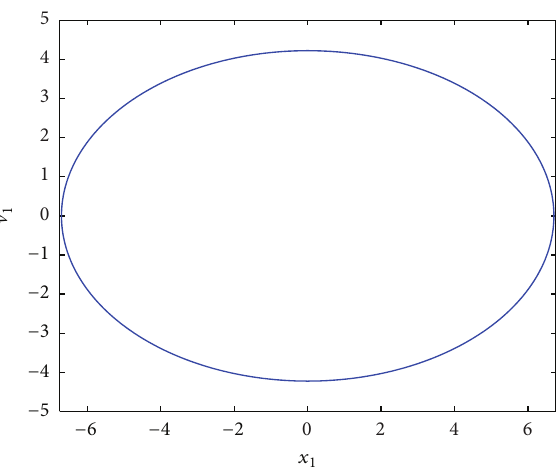
Figure 2: Phase portrait of the oscillator 𝑀 1 in (𝑥 1 , V 1 ) plane.